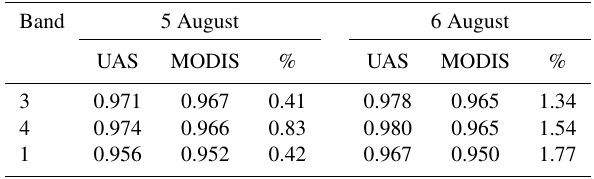
Table 1. Mean NBAR values from MODIS and the UAS on 5 and 6 August for bands 3, 4, and 1. Percentage differences are calculated based on the mean of the two